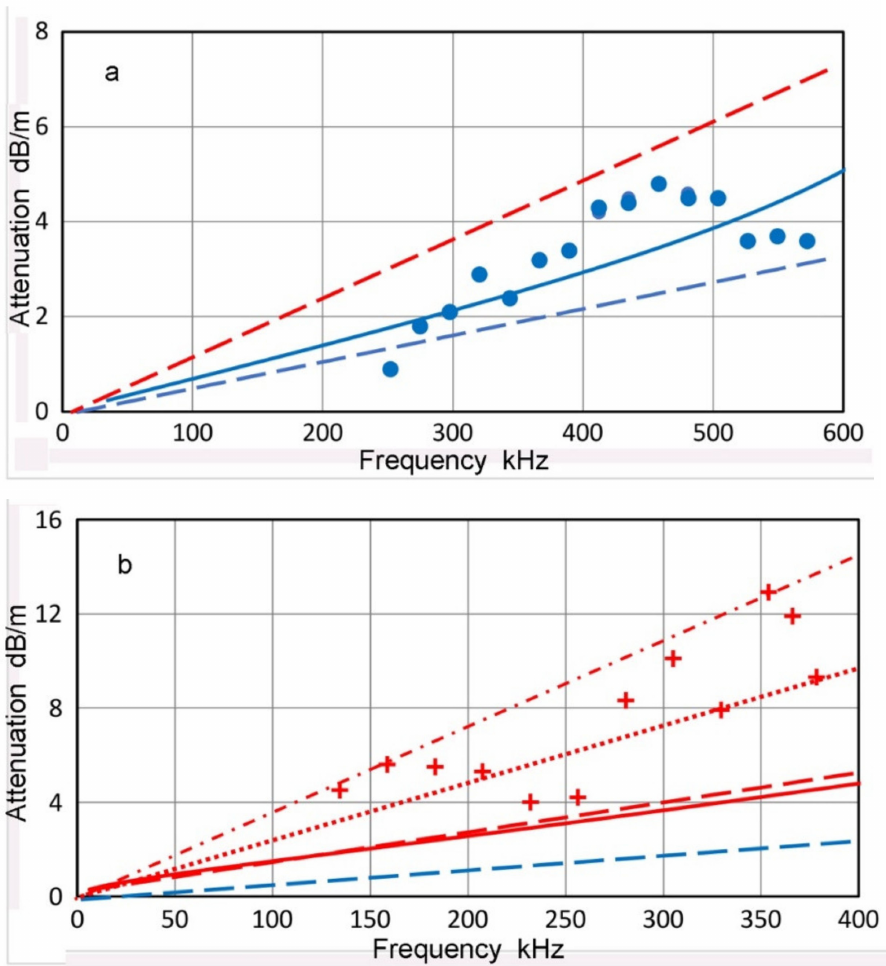
Figure 10. ( a ) α –S o values for Al-7475 of 2.7-mm thickness. Blue dots are for the data with Olympus V101 as Tx and KRN-BB-PC as Rx. Calculated α –S o (solid blue curve), α L and α T (blue and red dashed lines) are also plotted. ( b ) α –A o values for Al-7475 of 2.7-mm thickness. Red + symbols for short-pulse excited KRN-BB-PCP as Tx and KRN-BB-PC as Rx. Calculated α –A o (solid red curve), α L and α T (blue and red dashed lines) are also plotted. Additionally, red dotted and dash-dotted lines are drawn to represent 2 α T and 3 α T